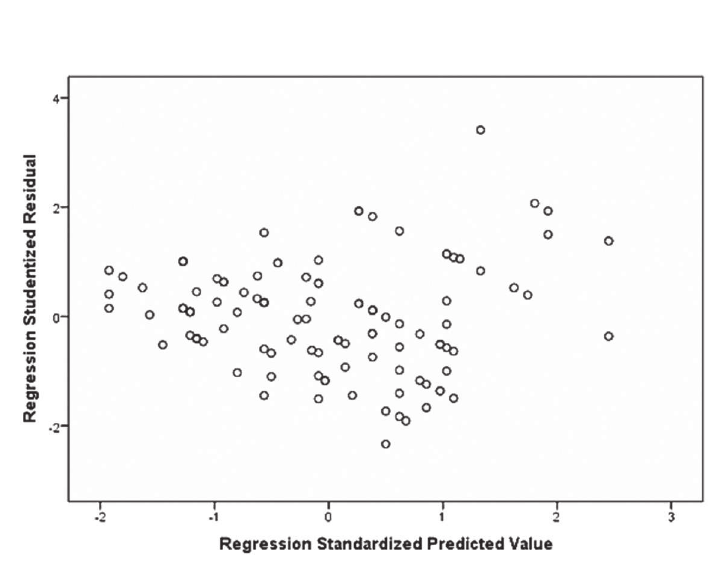
Figure 2. Scatterplot dependent variable: residual